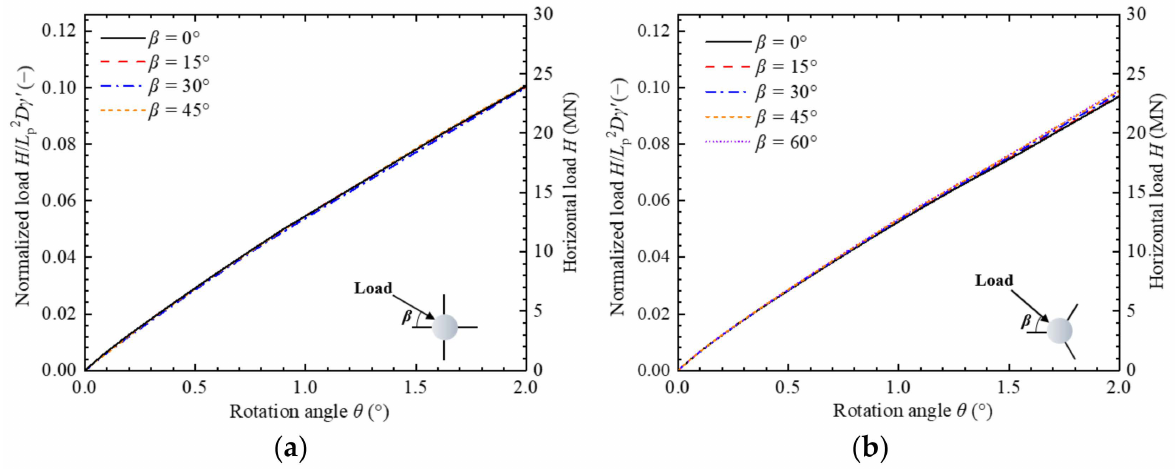
Figure 18. Effect of wing load orientation on the load capacity of winged monopiles: ( a ) a four-wing monopile; and ( b ) a three-wing monopile.